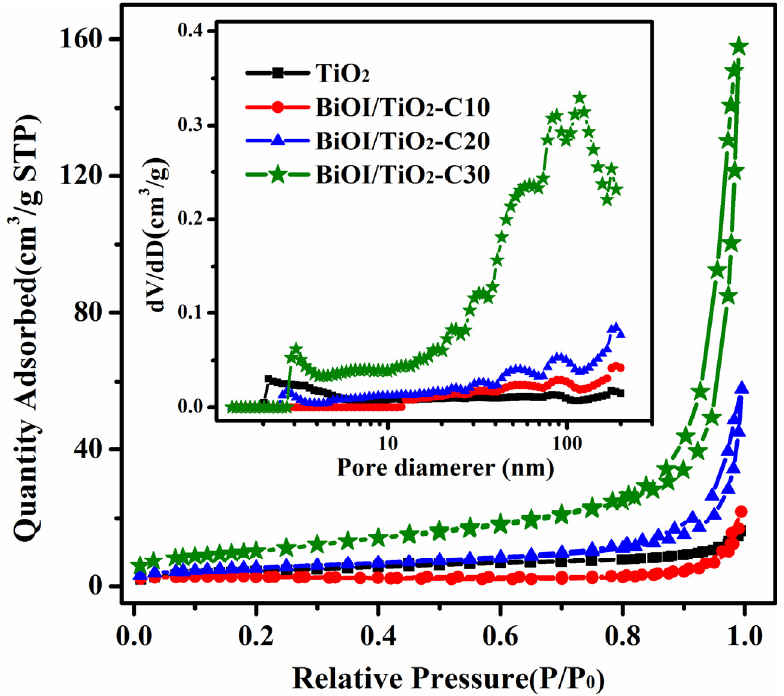
Figure 5. Typical N 2 gas adsorption desorption isotherms of different samples and their corresponding pore ‐ size distributions (inset). Table 1. SILAR cycles, BET specific surface area and photocatalysis reaction rates of different samples.